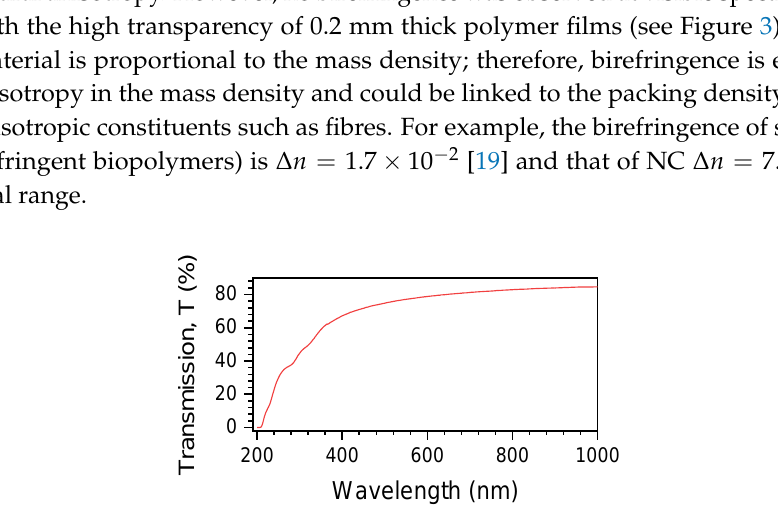
Figure 3. Optical transmission spectrum of 2 wt%. NC-containing polymer; thickness d = 190 ± 15 µ m. NC fibres were shown to increase the temperature diffusivity by approximately two times, even at very small (2 wt%) loading of NC. The same measurement technique can be used for other